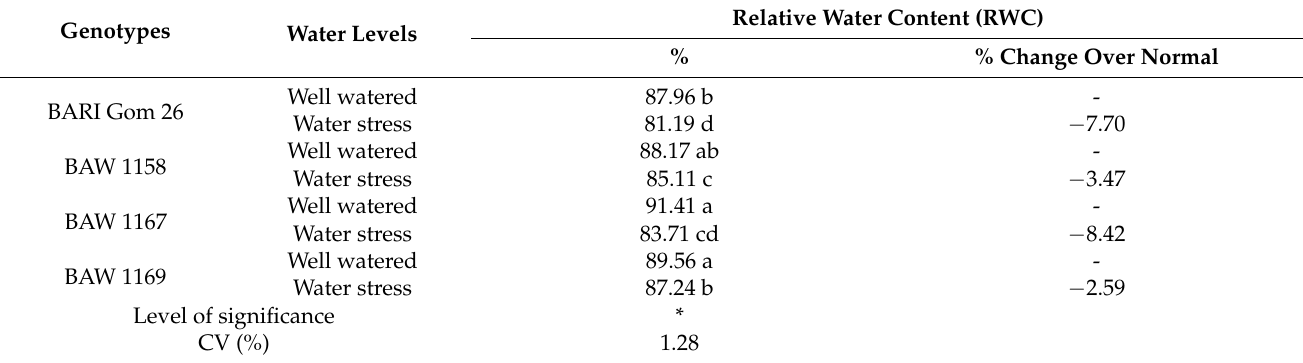
Table 6. Effect of DS on the relative water content in the flag leaf of different wheat genotypes at 12 DAA.